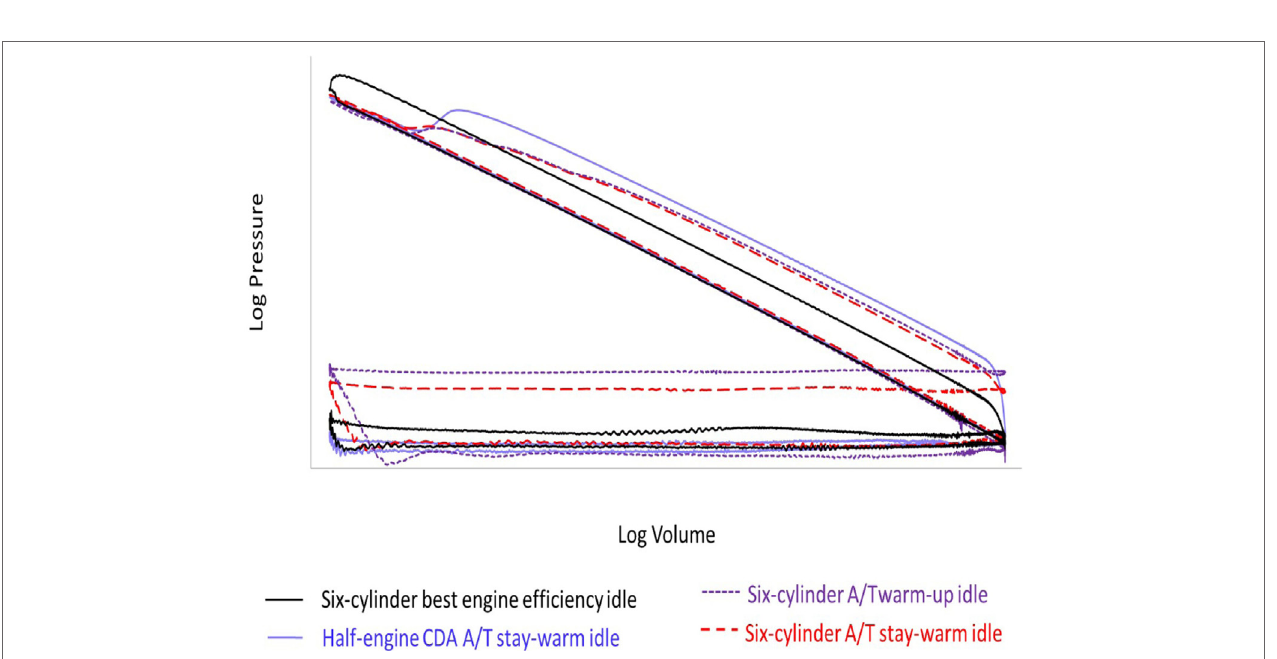
FigUre 11 | Experimental PV diagrams for the four strategies at 800 RPM/1.3 bar. The pumping loops are the largest for the “Six-cylinder A/T warm-up idle” and “Six-cylinder A/T stay-warm idle” strategies as a result of completely closed VGT positions and delayed SOI. The increased pumping work requires higher fuel consumption, increasing engine-outlet temperatures and flow rates for A/T warm-up. The pumping loop is smallest for the “Half-engine CDA A/T stay-warm idle” strategy as a result of lower pumping work through decreased displaced volume.